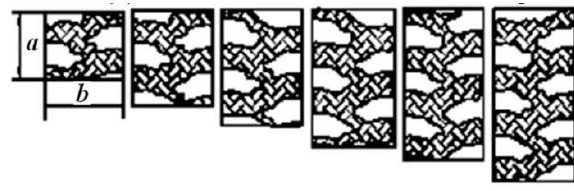
Figure 3. A change in the dimensions of the wheel-to- ground contact depending on the normal load